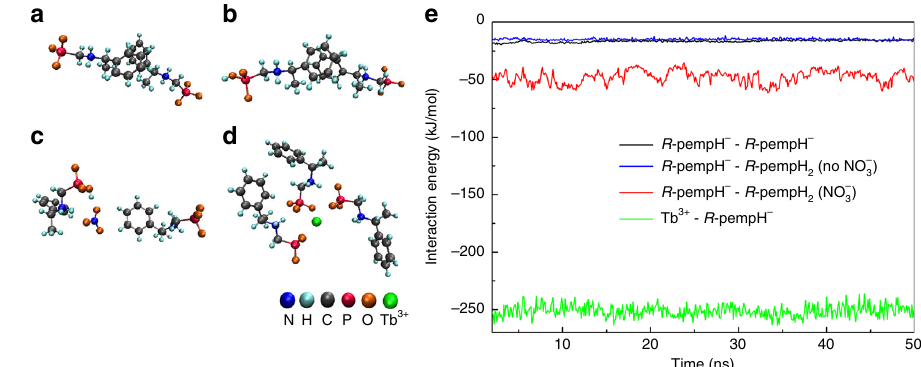
Fig. 7 The setup and result of all-atom molecular dynamics simulations. The initial conformation for different systems (the coordinates are adopted from the experimental crystal data): a two R -pempH − molecules; b one R -pempH − molecule and one R -pempH 2 molecule; c one R -pempH − molecule and one R - pempH 2 molecule in the presence of NO 3 − ; d one Tb 3+ and three R -pempH − molecules. The water molecules and counterions are not shown for clarity. e Interaction energy among different molecules in the